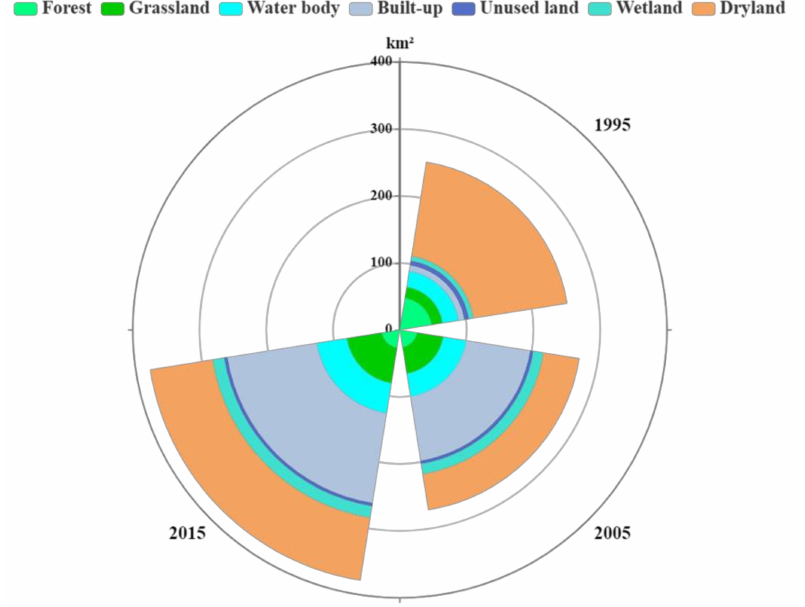
Figure 6. Changes in the land-use types in the Yihe River Basin in 1995, 2005, and 2015 compared to 1990.